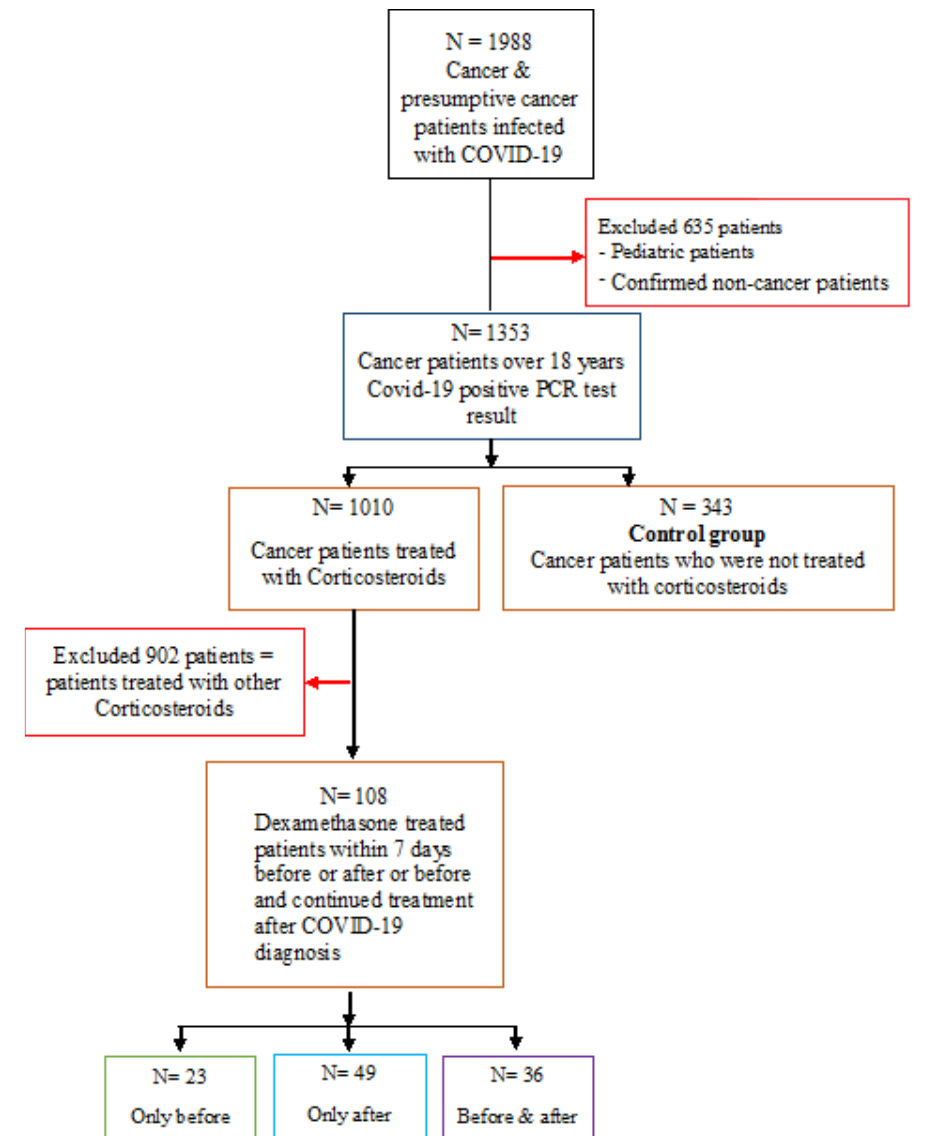
Figure 1. Summary of sampling strategy, inclusion and exclusion